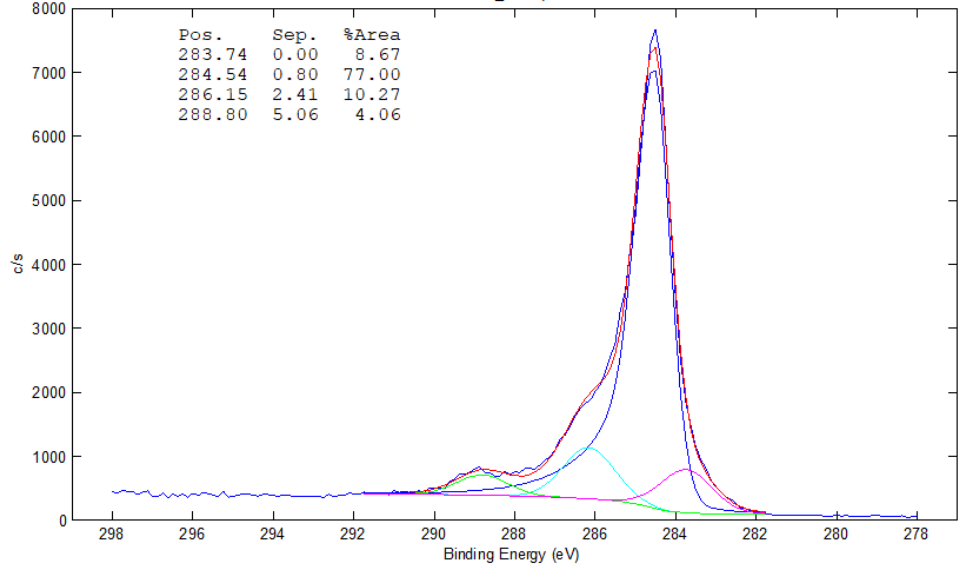
Figure 4. XPS analysis of MWCNT, raw material without any treatment.